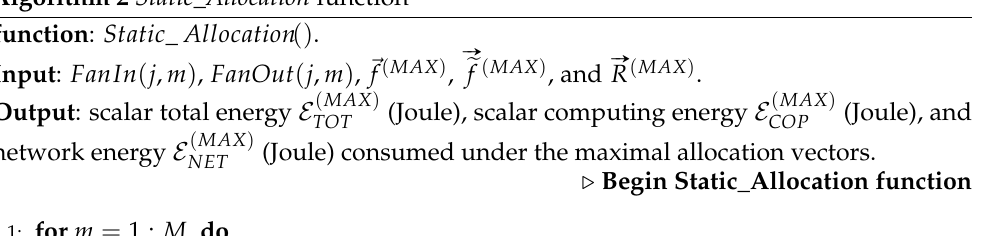
Algorithm 2 Static_Allocation